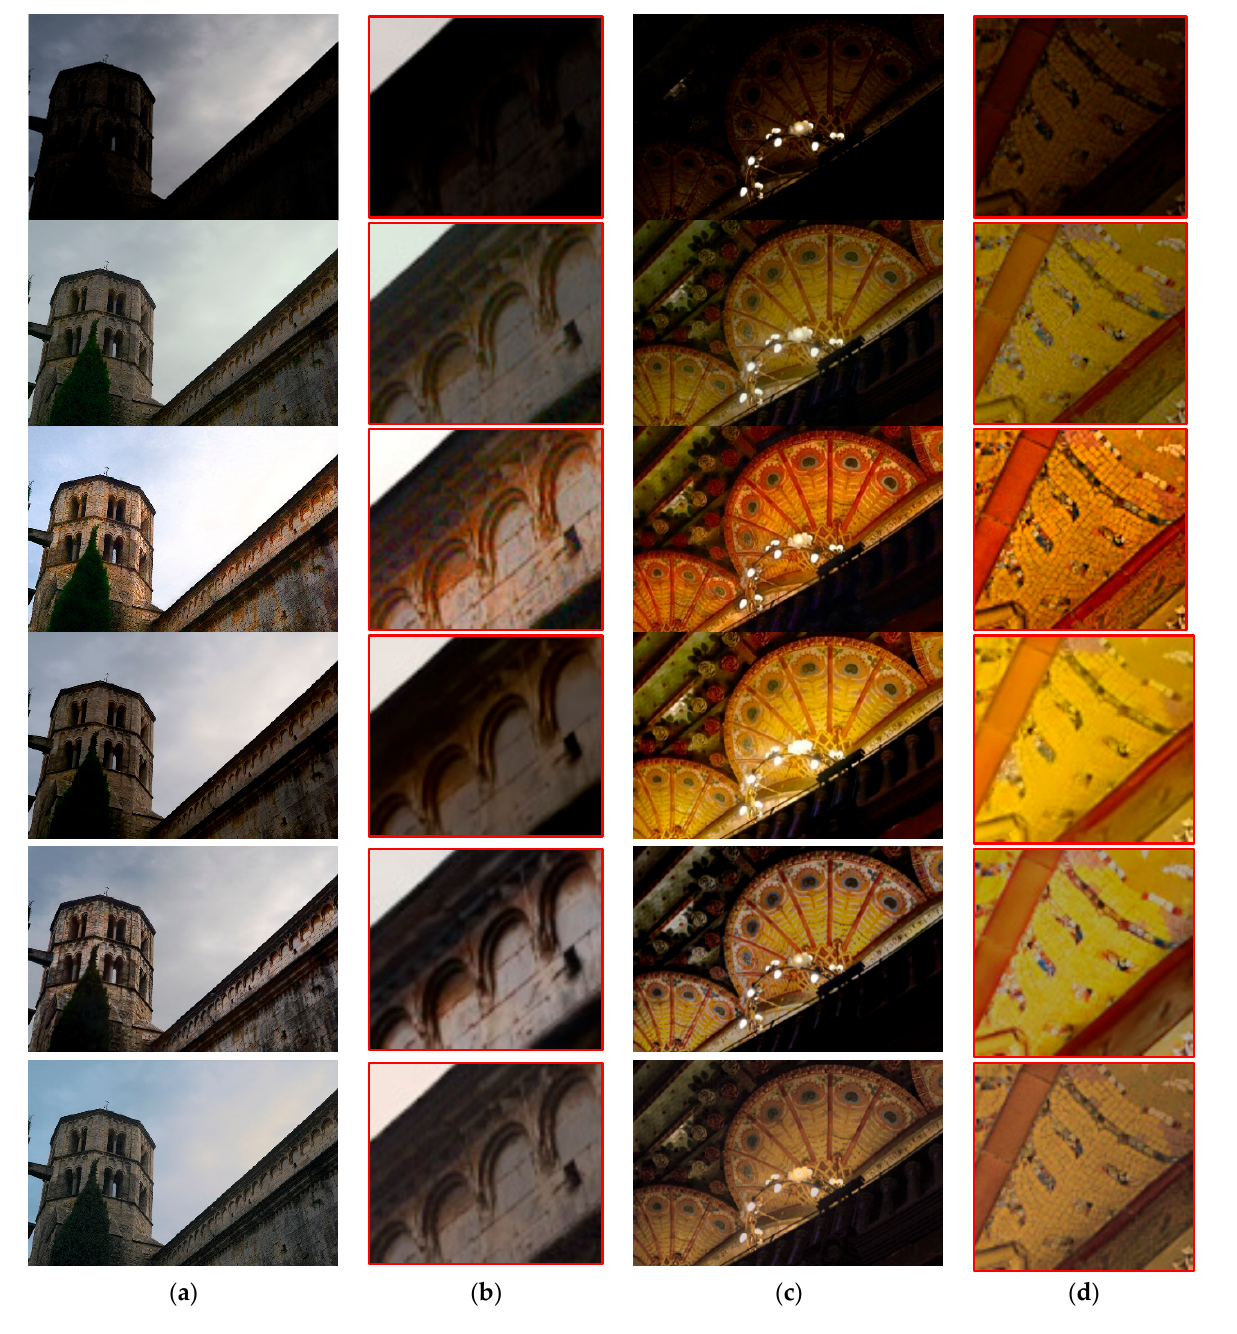
Figure 6. Visual comparisons of without-ground-truth images: (from top to bottom) real low-light image, MSR-net, retinex-net, MBLLEN, KinD, and proposed method. ( a ) test image3, ( b ) partially zoomed-in view of ( a ), ( c ) test image4, and ( d ) partially zoomed-in view of ( c ).